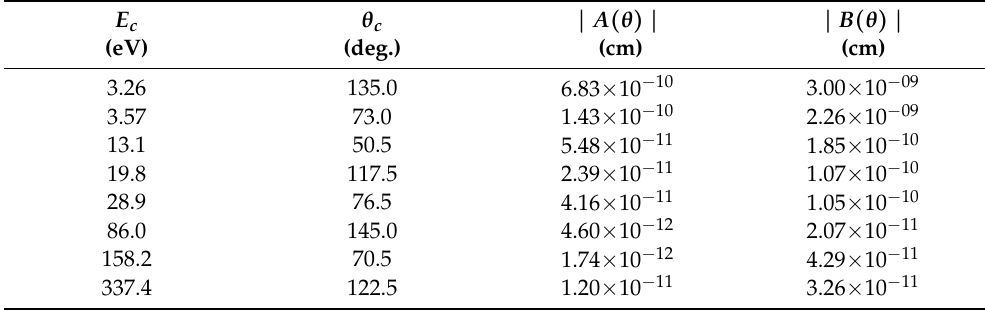
Table 3. The energy and angular positions and the values of direct and spin-flip scattering amplitudes of the deep minima (DM) in the DCS for elastic e − − Cu scattering [6]. E c θ c